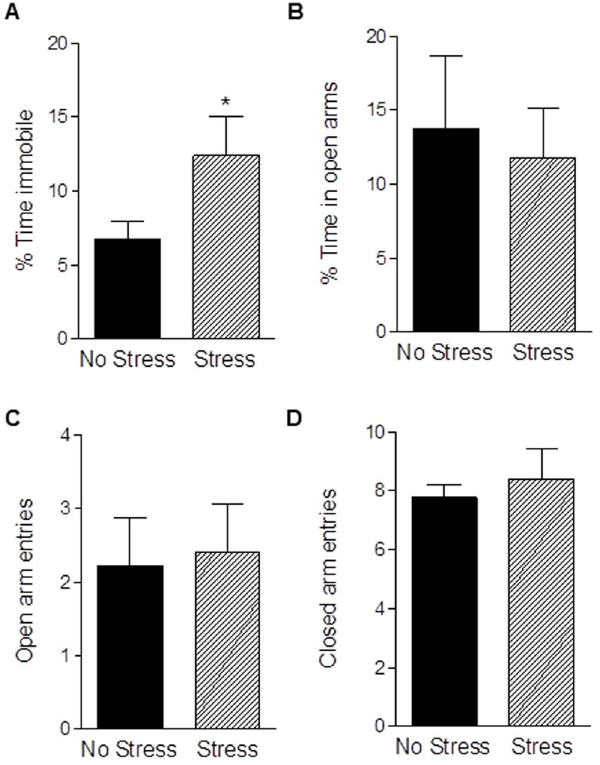
Figure 2. Chronic gestational stress increases postpartum depressive-like, but not anxiety-like, behaviors. Exposure to chronic stress during pregnancy increased the percentage of time postpartum females spent immobile in the forced swim test (a). Chronic gestational stress did not alter anxiety-like behavior in the elevated plus maze. Stressed and unstressed mothers spent a similar percentage of time (b) and made a similar number of entries (c) into the open arms. Locomotor activity, as assessed by closed arms entries in the EPM (d), was unaffected by gestational stress. Bars represent mean 6 SEM, * p , 0.05.